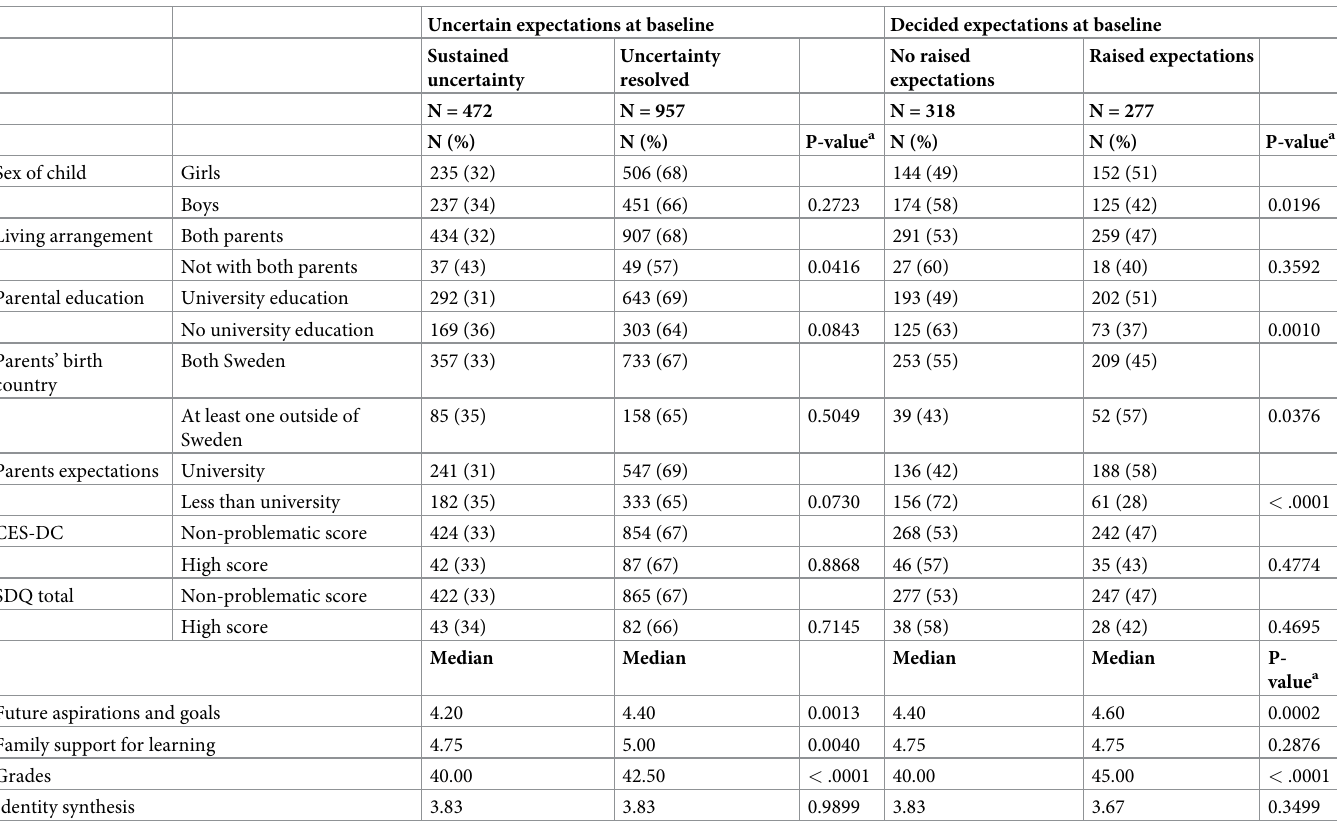
Table 2. Baseline characteristics and change in aspirations between 7 th and 9 th grade among those with undecided expectations and those with decided expectations below university in 7 th